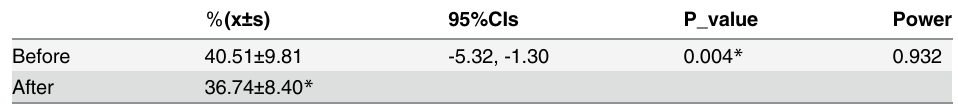
Table 4. The RV/TLC of patients before and after the obturator placement. ％ (x ± s) Before